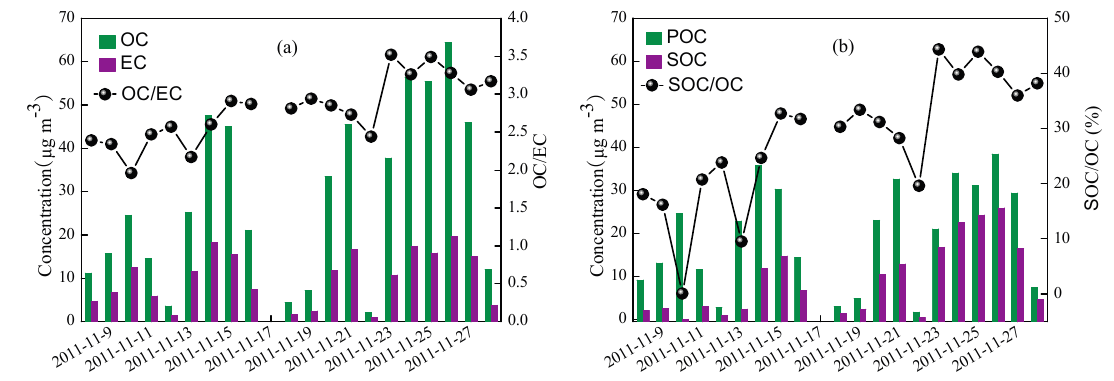
Figure 4. Variations of OC, EC, and OC/EC ( a ) as well as primary organic carbon (POC), secondary organic carbon (SOC), and SOC/OC ( b